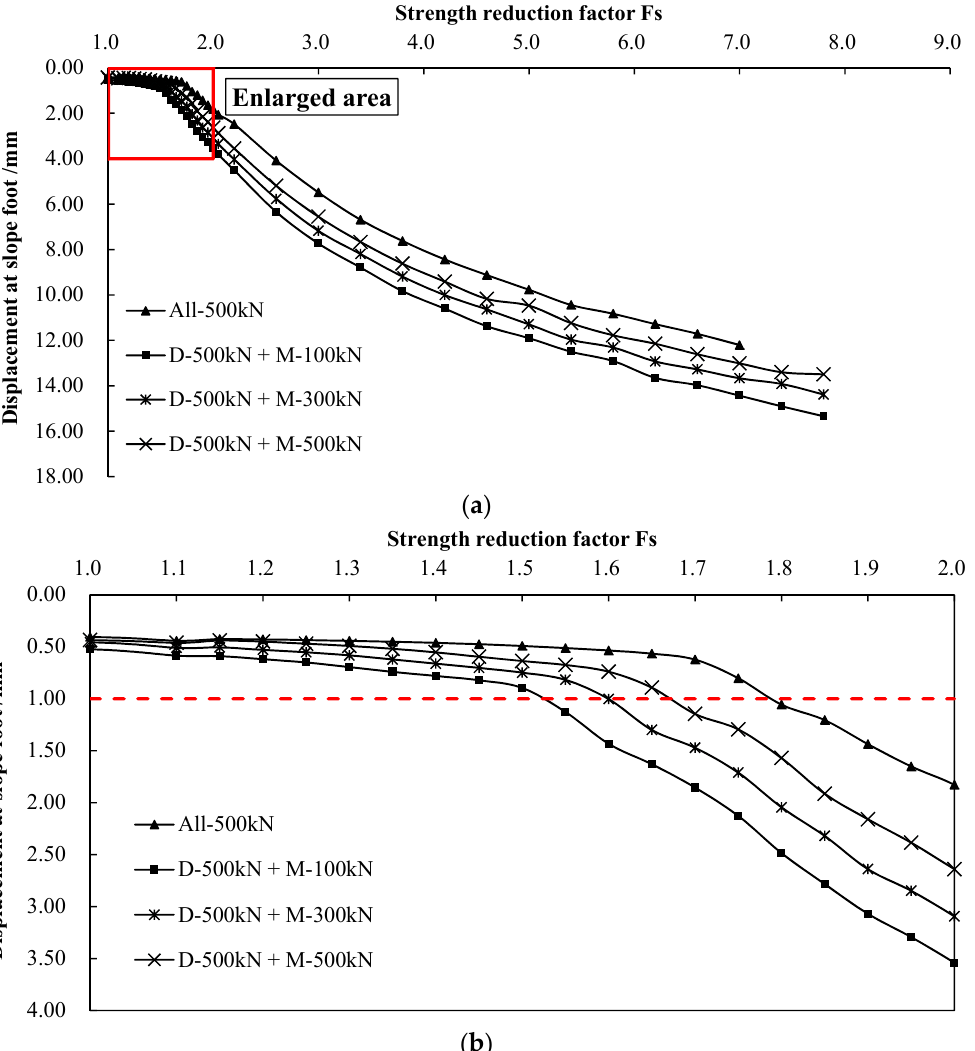
Figure 12. ( a ) The relationship between the displacement of the slope foot and the strength reduction factor under different schemes of prestressed anchor cables; ( b ) enlarged drawings of the enlarged sections in Figure 12b.